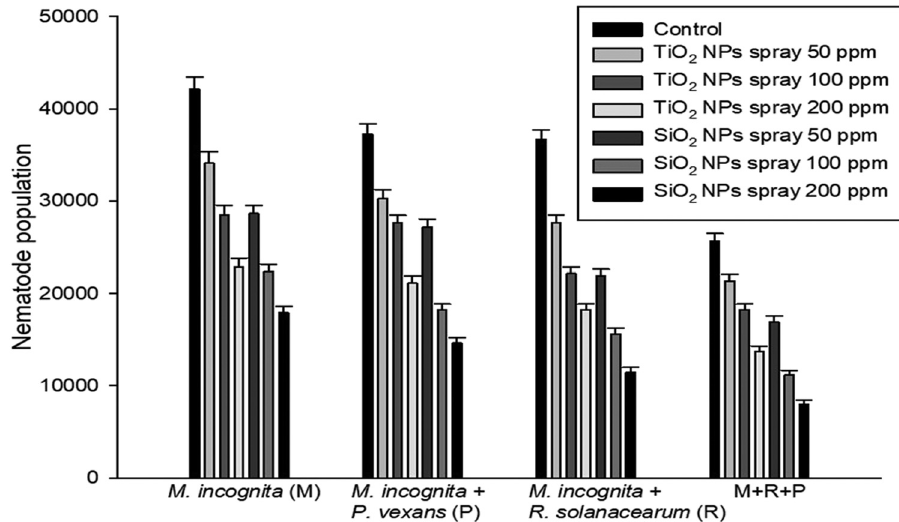
Figure 5: In fl uence of SiO 2 - NPs and TiO 2 - NPs on the multiplication of M. incognita ( M ) inoculated alone ( M ) and in combination with P. vexans ( P ) and R. solanacearum ( R ) . Error bars re fl ect the standard deviation.